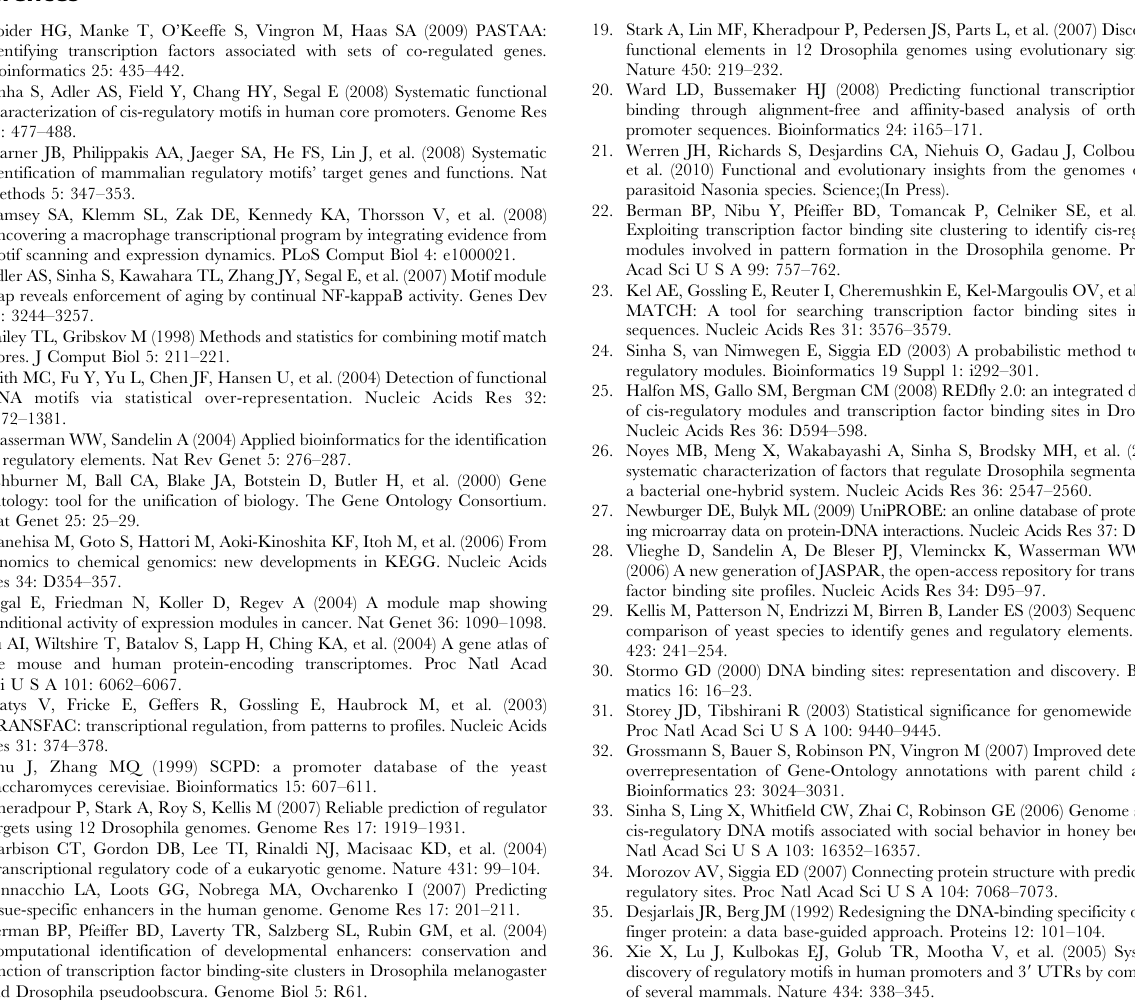
Table S1 Correlation between motif characteristics and amena- bility to specific methods.